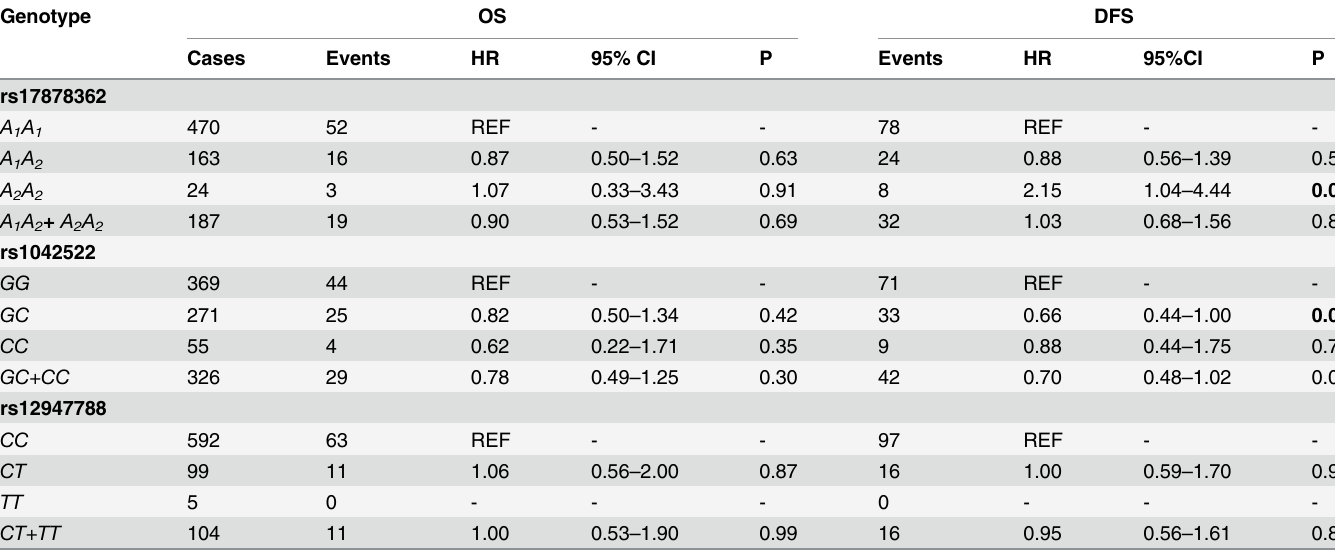
The SNP rs17884306 was monomorphic in cases, thus not